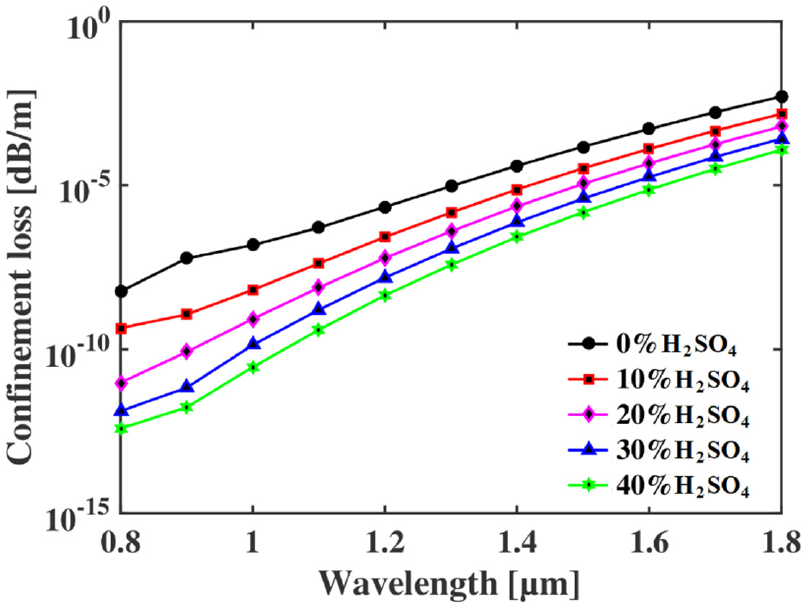
Figure 5. Confinement loss of the proposed sensor at different wavelengths for different concentra- tions of H 2 SO 4 .